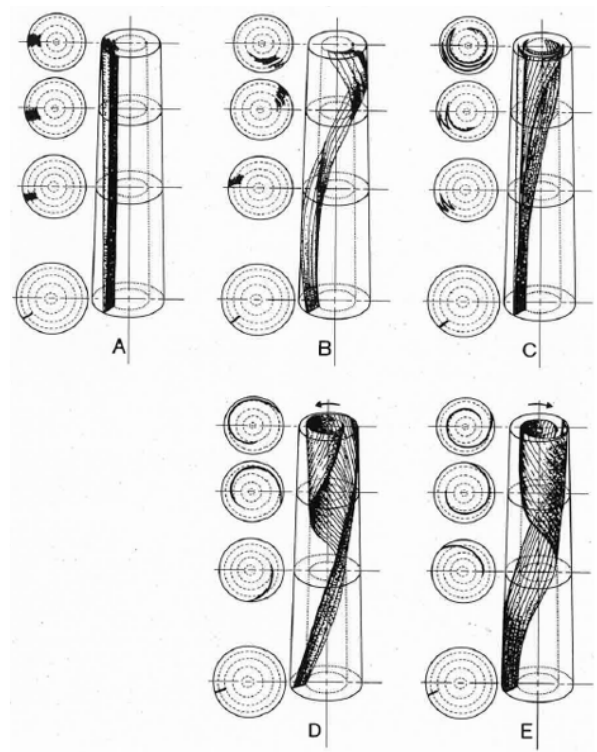
Figure 5. Ascent of dye solutions in stems of standing trees, after injections radially at the base of the stem. A: sectorial straight; B: sectorial winding; C: interlocked; D: spiral turning left; E: spiral turning right (In Harris 1989, after Vité